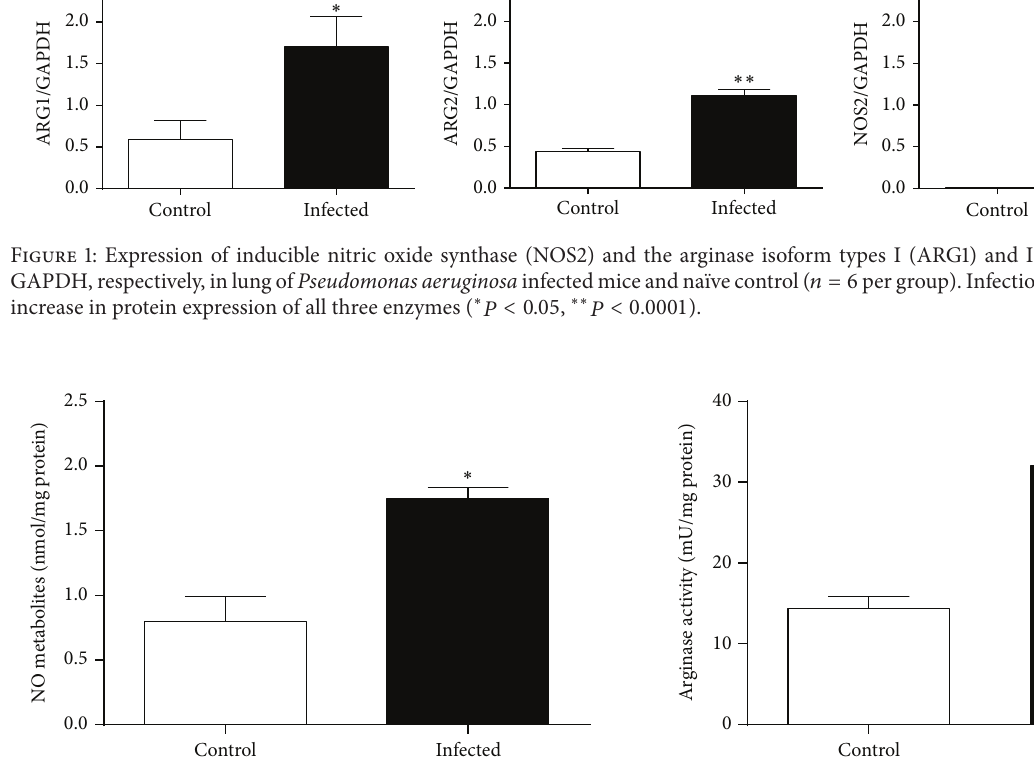
Figure 3: Arginase activity measured in lung homogenates of mice infected with Pseudomonas aeruginosa and noninfected controls in vitro ( 𝑛 = 4 per group) ( ∗ 𝑃 < 0.05